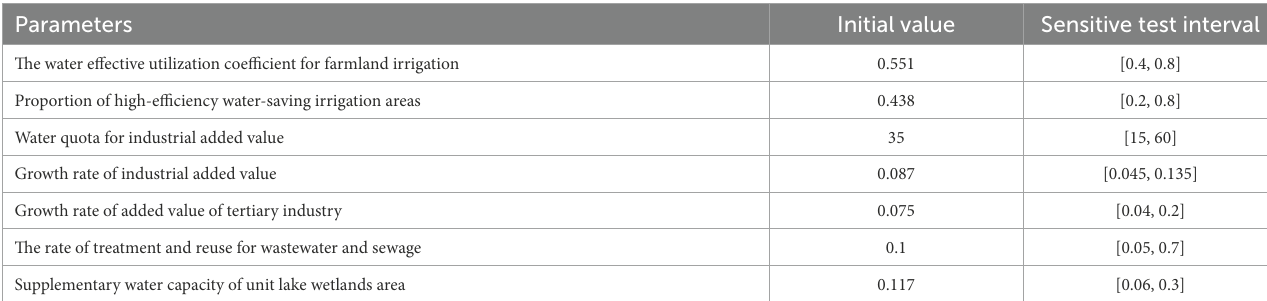
TABLE 4 Parameter sensitivity analysis interval setting. Parameters Initial value Sensitive test